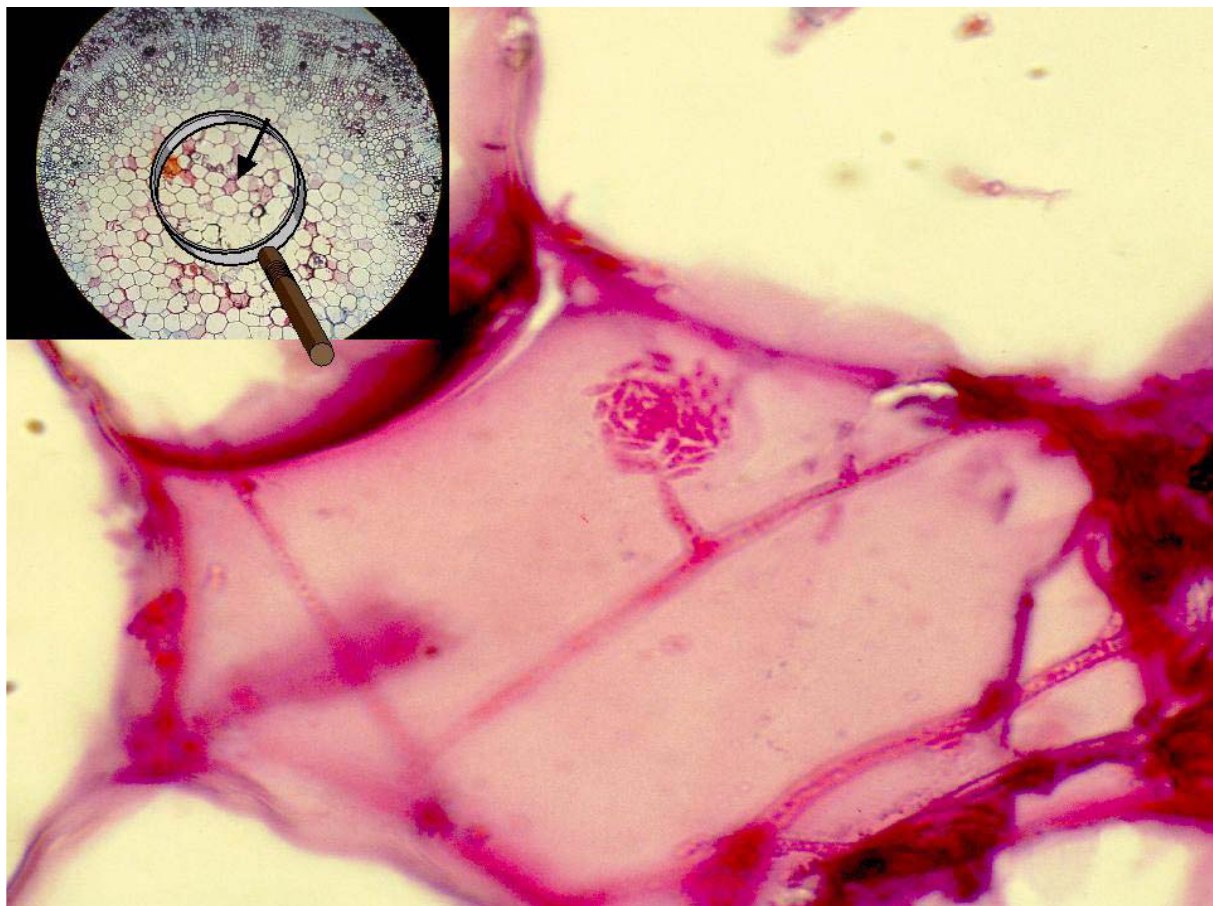
Fig. 4. Cross-section of an infected stem showing conidiophore and spores of Phaeoacremonium inflatipes in the intercellular space of the pith. (cid:1) = 1000.